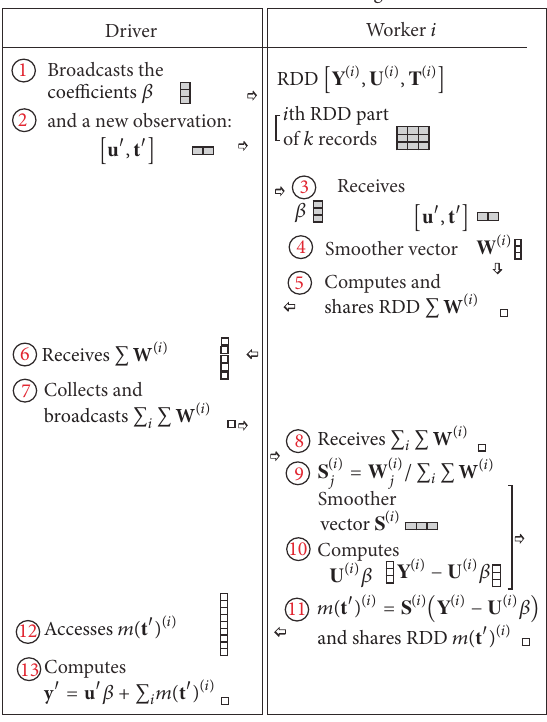
Figure 3: PLM parallel